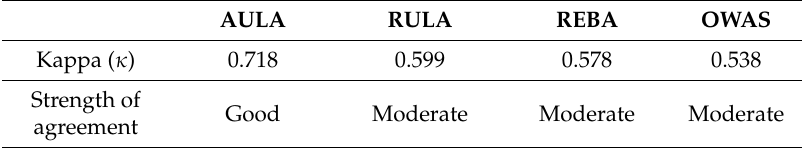
Table 4. Quadratic weighted kappa analysis of all ergonomic risk evaluation tools.